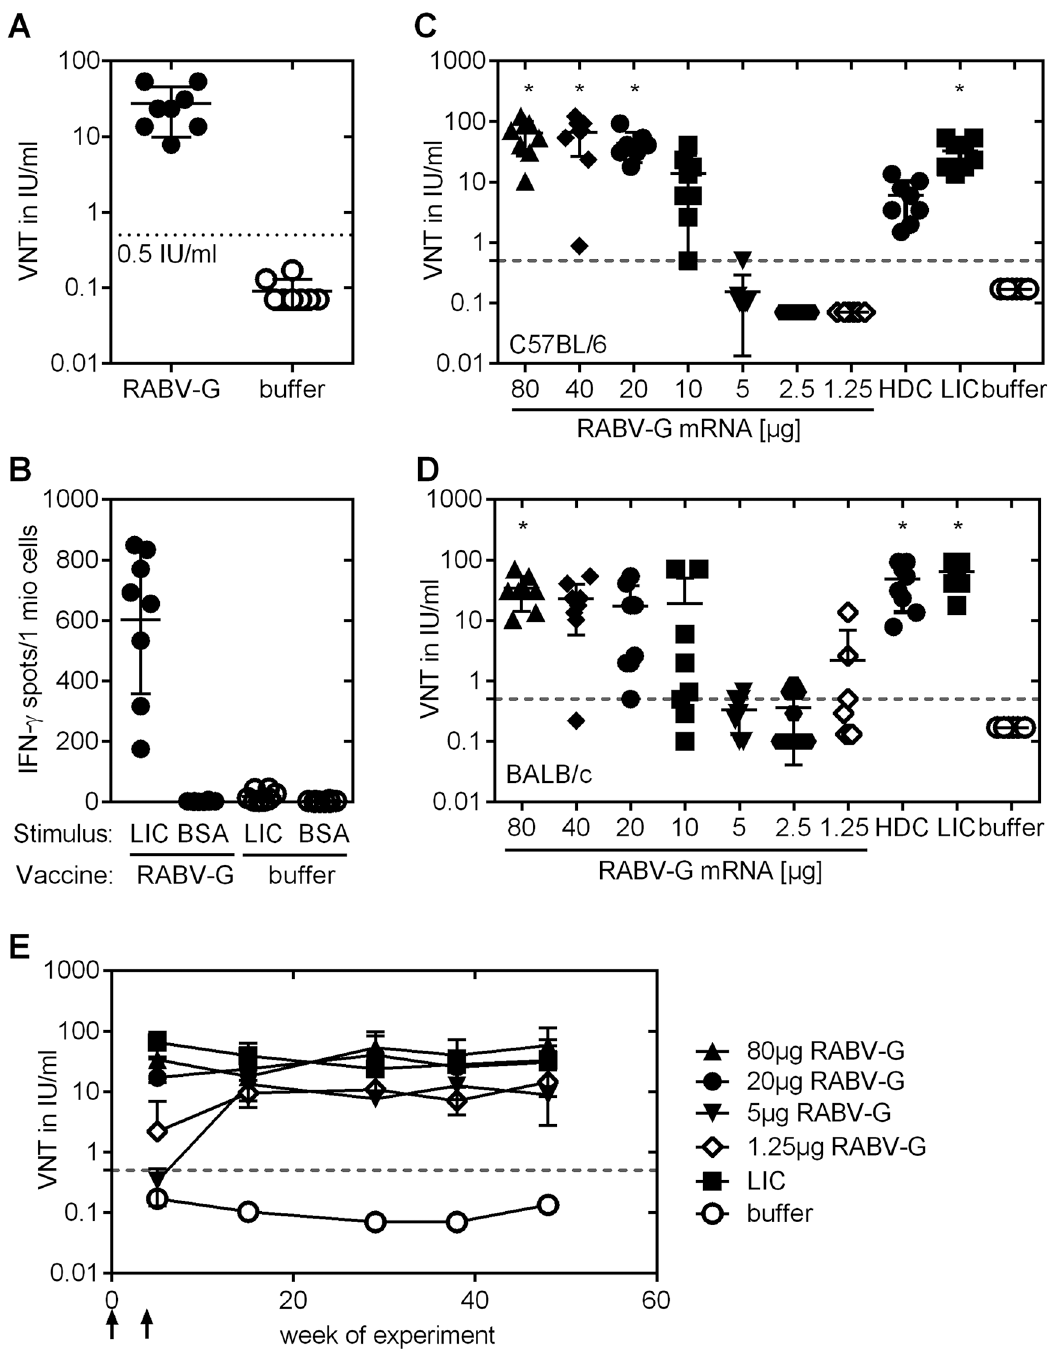
Fig 1. Antigen-specific immune response in mice. (A) Virus-neutralizing (VN) antibody titers in the serum of female BALB/c mice were measured using Fluorescent Antibody Virus Neutralization (FAVN) test. Animals were vaccinated twice with 80 μ g RABV-G mRNA or buffer at day 0 and 21. 35 days after the first vaccination, serum was collected. The dotted line at 0.5 IU/ml is considered as a correlate of protection. (B) Splenocytes from the same mice were isolated for the analysis of antigen specific T cells via ELISPOT analysis at day 35 after the first immunization. (C , D) VN titers dose- response profile in female (C) C57BL/6 and (D) BALB/c mice after RABV-G mRNA vaccination compared to licensed vaccines. Animals were vaccinated with RABV-G mRNA, licensed vaccines (HDC or Rabipur (LIC)) or buffer on study days 0 and 21. RABV-G mRNA was applied intradermally (i.d.) at doses of 80 μ g, 40 μ g, 20 μ g, 10 μ g, 5 μ g, 2.5 μ g